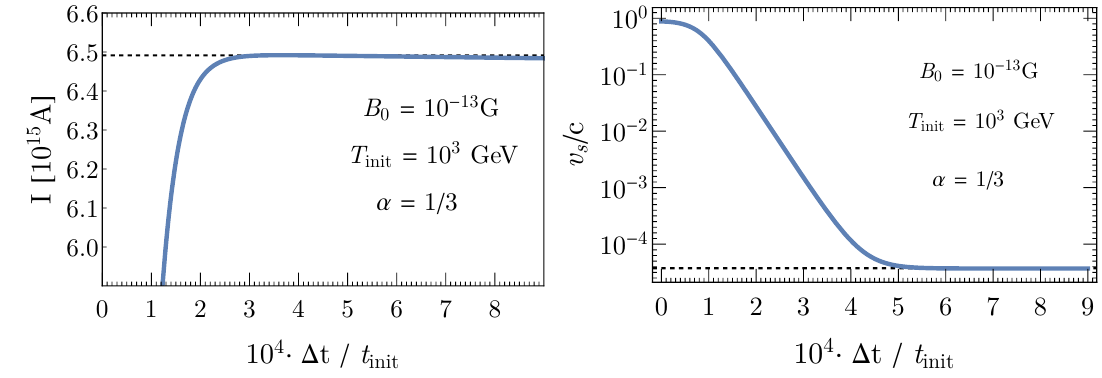
Figure 2 . Evolution of I and v in the transient stage after t init . Left : I ( t ) . Right : v s ( t ) . The dashed lines indicate the plateau values from eq. (5.12). f